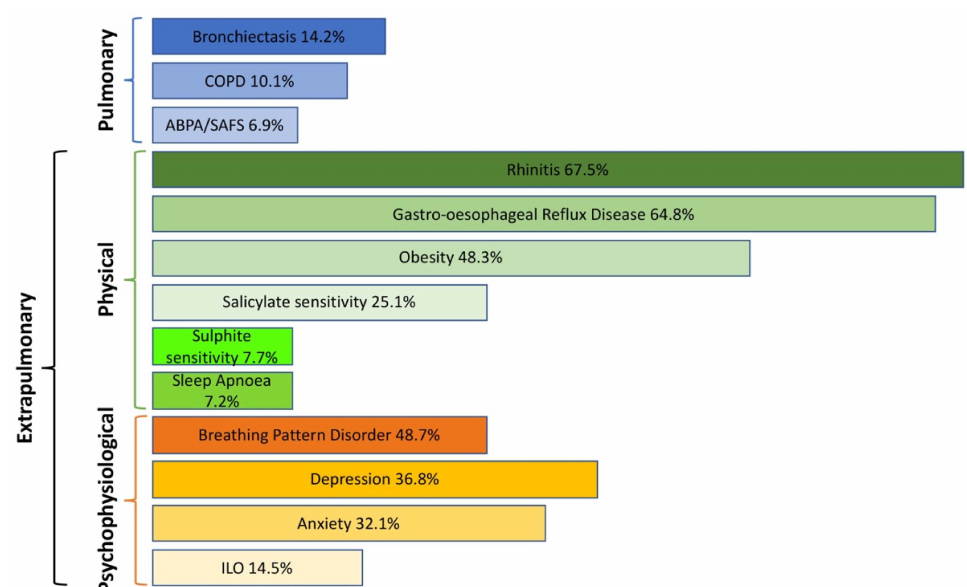
Figure 2. Treatable Traits in the Wessex AsThma CoHort of difficult asthma (WATCH) study. ABPA— Allergic Bronchopulmonary Aspergillosis, SAFS—Severe Asthma with Fungal Sensitisation, COPD— Chronic Obstructive Pulmonary Disease, GORD—Gastro-oesophageal reflux disease, OSAHS— Obstructive Sleep Apnoea-Hypopnoea Syndrome, ILO—Inducible Laryngeal